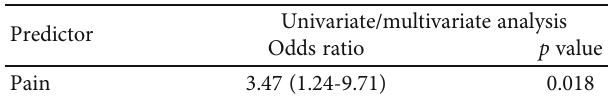
Figure 2: Factors reported in hospitalized patients with poor sleep quality on the third day. ∗ Other factors included cold temperature, hot temperature, cough, being in di ff erent place, itching, dyspnea, hungry, mosquito, polyuria, procedure, and disturbance by visitors. Table 6: Predictors of poor sleep quality in hospitalized patients on the third